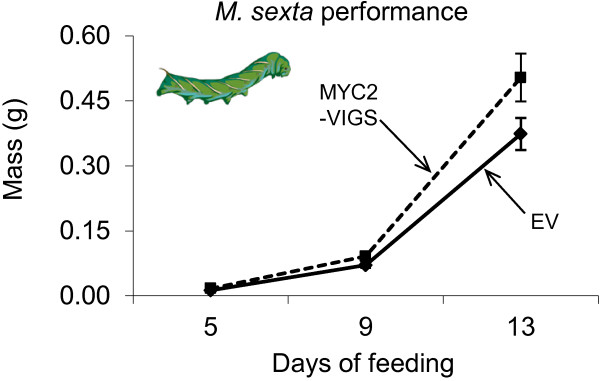
Performance of M. sexta on EV- and MYC2-VIGS plants. Neonates (n=20) of the specialist herbivore, M. sexta, were fed on EV and MYC2-VIGS N. attenuata plants for 13 d and their masses (mean ± SE) were determined on the 5th, 9th and 13th day to compare their relative growth performance. No significant differences were observed in mass gained among caterpillars fed on EV or MYC2-VIGS plants.